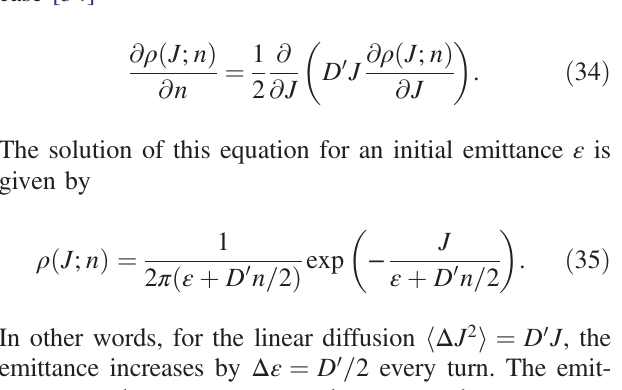
figure. The diffusion rate depends on the tune except for turn-by-turn noise. For large τ and ν ¼ m= ð n þ 1 Þ , with integers m and n , a small denominator for ( n ¼ k ) yields a high diffusion rate. The dependence on the tune is less strong for other tune values.